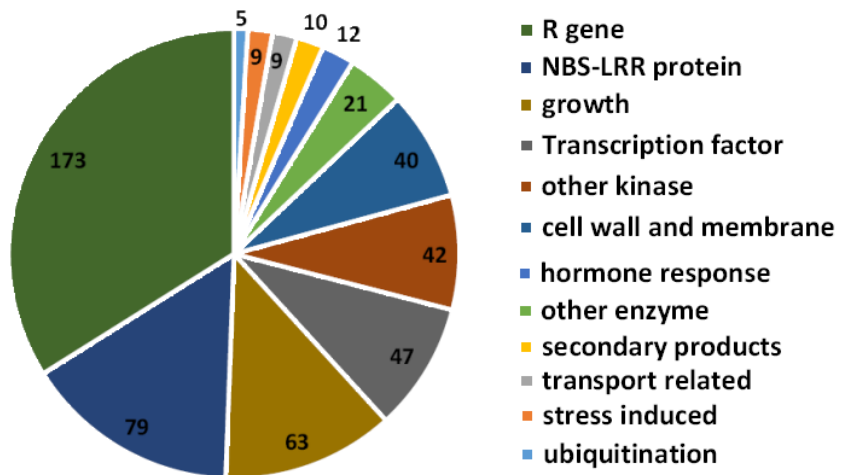
Figure 4. The classification of predicted target genes with known function in potato.